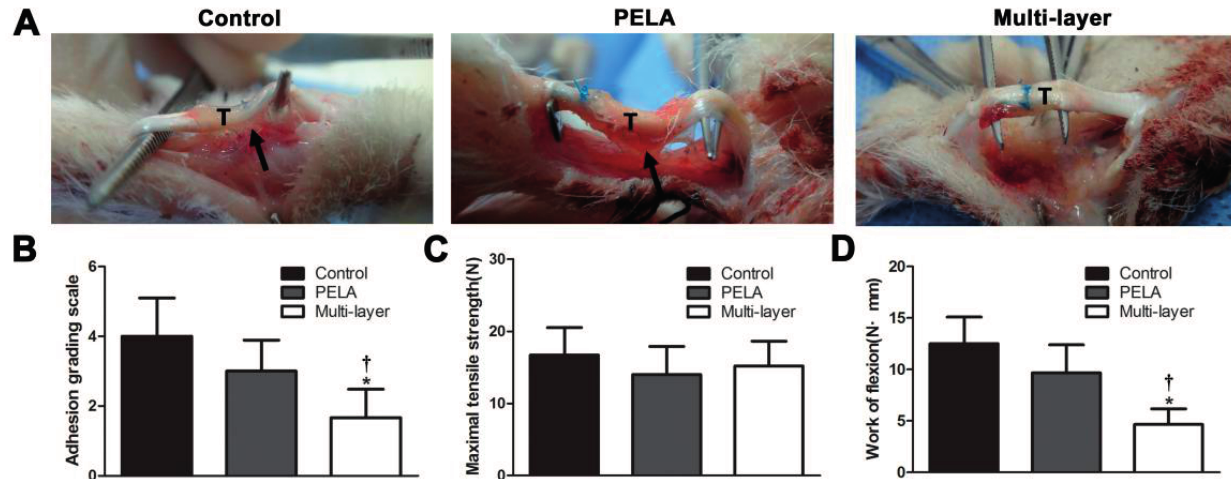
Figure 2. ( A ) Gross evaluation of the rabbit flexor digitorum profundus (FDP) tendon model in the untreated control group, PELA membrane group, and multi-layer membrane group. Tendon (T) is indicated in the figures and adhesion tissue is pointed to using black arrows. Tendon repair and peritendinous adhesions are evaluated by determining macroscopic evaluation of tendon adhesions ( B ), maximum tensile strength ( C ), and work of flexion ( D ). * p < 0.05 compared with control group; † p < 0.05 compared with PELA membrane group. Data are expressed as mean ± SEM for six